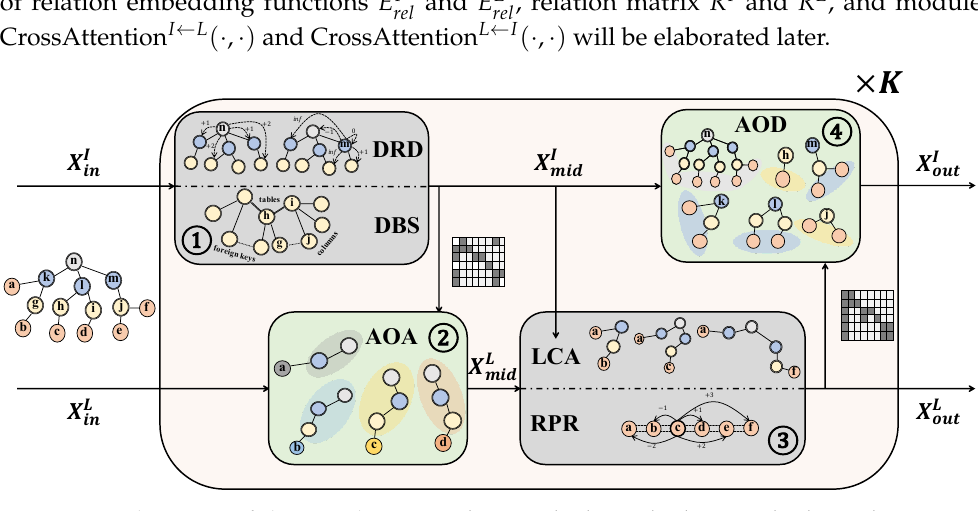
Figure 4. Architecture of the encoder. DRD: directional relative depth . DBS: database schema . LCA: lowest common ancestor . RPR: relative position relation . AOD: attention over descendants . AOA: attention over ancestors . The dataflow is ordered by the